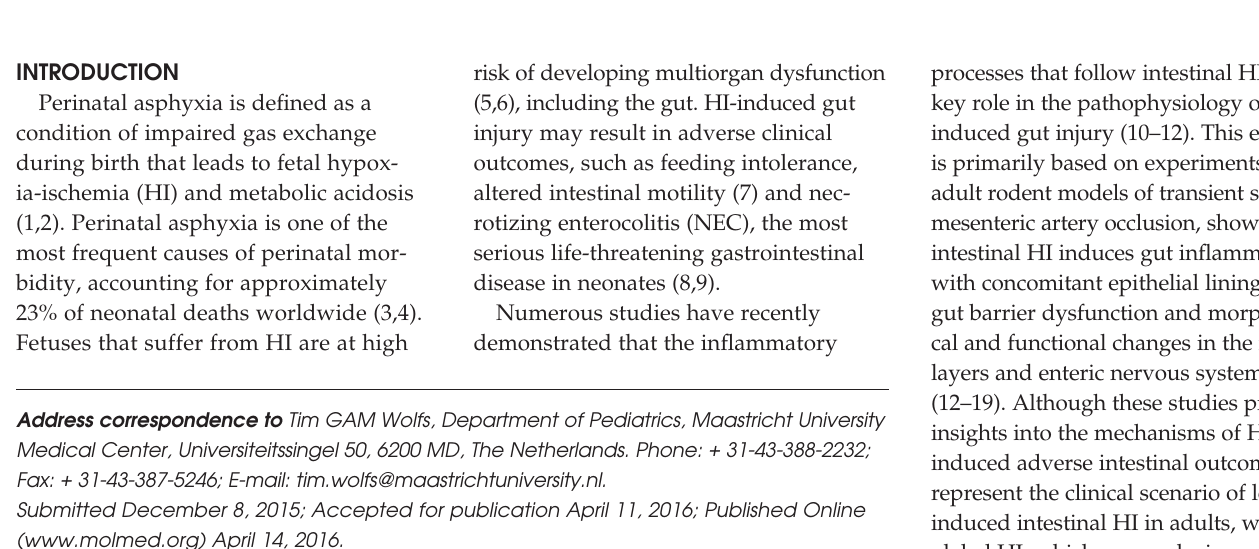
processes that follow intestinal HI play a key role in the pathophysiology of HI- induced gut injury (10–12). This